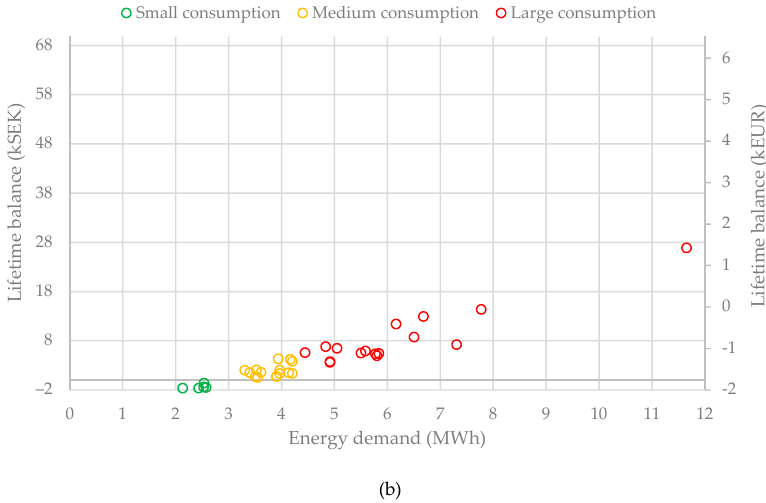
Figure 11. Cumulative balance over the lifetime of the system against the annual energy demand. The households have been divided in three groups, each of 16 specimens, according to their cumulative consumption: ( a ) LEC Gratis; and ( b ) LEC LCOE.